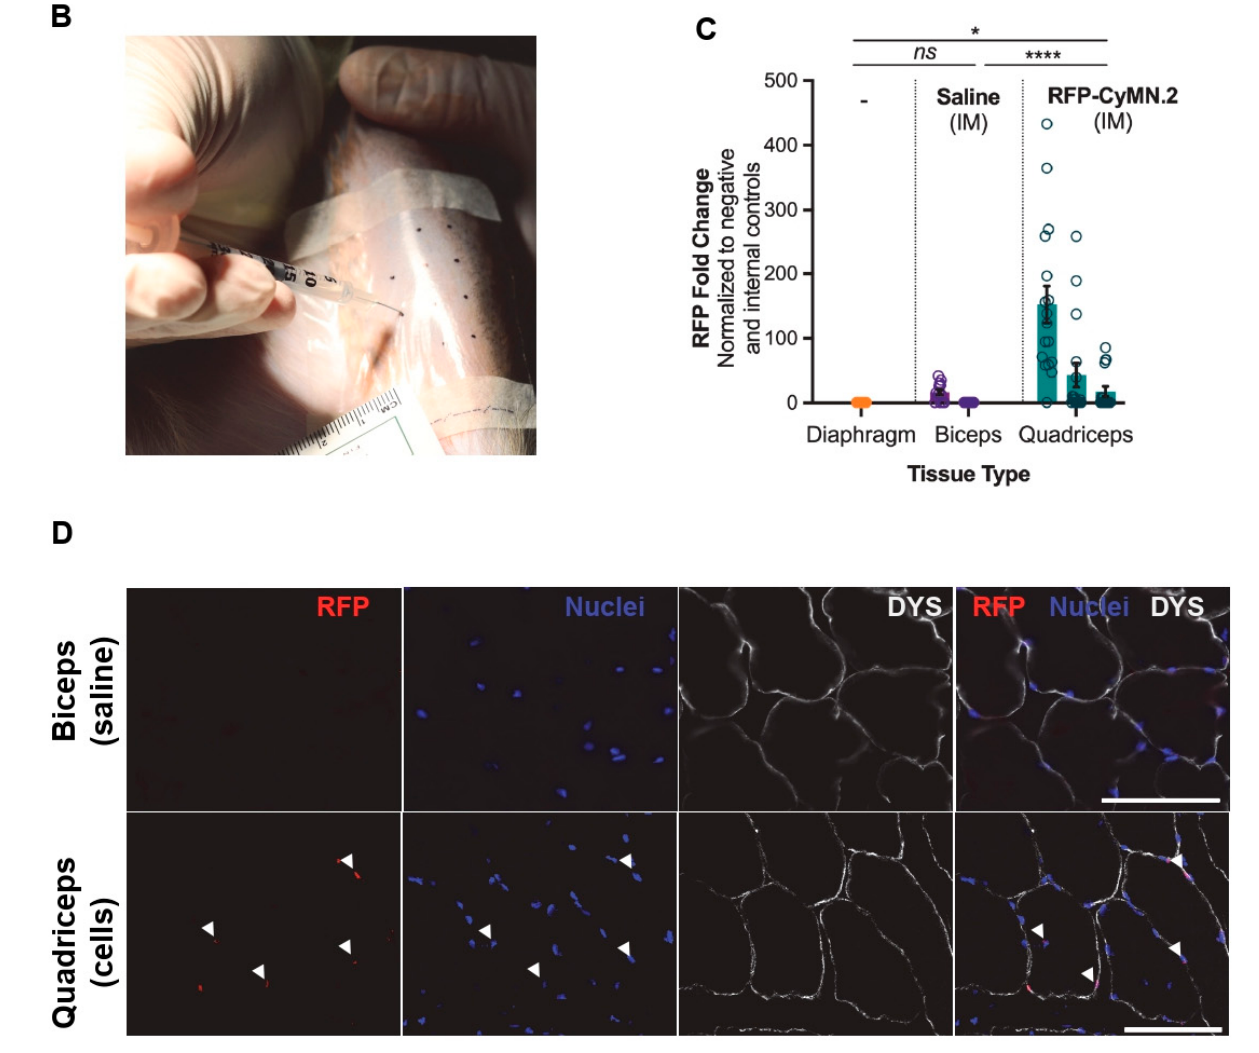
Figure 5. NHP iPAX7 iPS-cell-derived myogenic progenitors show engraftment capacity in NHP: ( A ) Schematic representation of the derivation of myogenic progenitors and transplantation in an NHP; ( B ) cells were suspended and injected IM at CTX-pre-injured sites using a grid pattern; ( C , D ) donor-derived RFP-labeled CyMN.2 iPAX7 myogenic progenitors are identified in the quadriceps of NHP recipient using qPCR and immunofluorescent assays: ( C ) Dot plot depicting fold change in